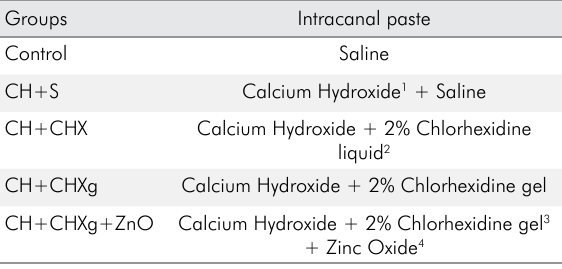
Table 1. Control and experimental groups (n = 20 for each). Groups